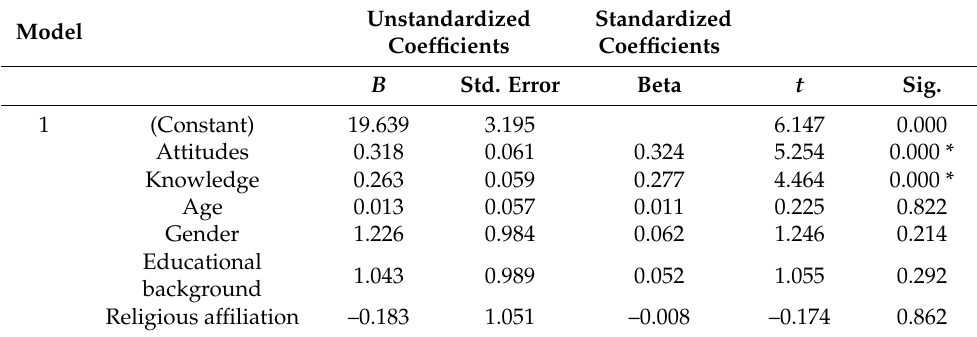
Table 7. The regression coefficient of the independent